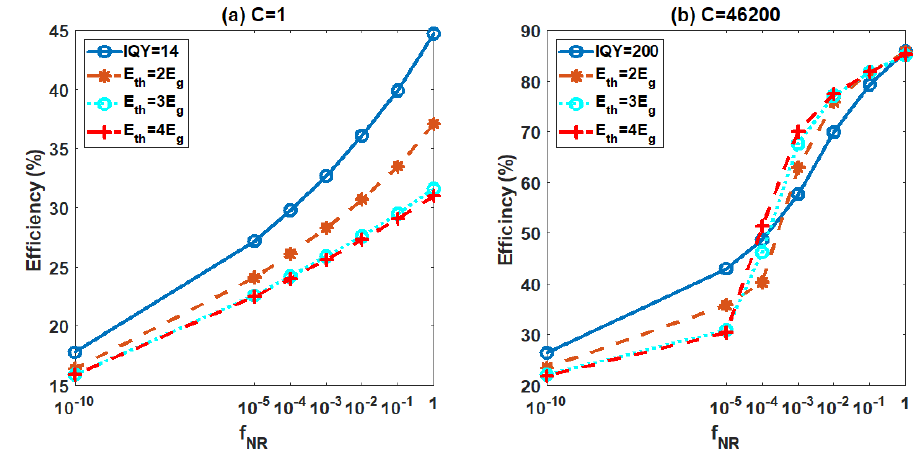
Figure 3. Theoretical maximum efficiency vs. variation of f NR (= 10 − 10 ,10 − 5 ,10 − 4 ,10 − 3 ,10 − 2 ,10 − 1 ,1). For this simulation, we used ideal quantum yield (IQY) and with three different threshold energies (E th = 2E g , 3E g , and 4E g ) for NQY. Appl. Sci. 2020 , 10 , x FOR PEER REVIEW